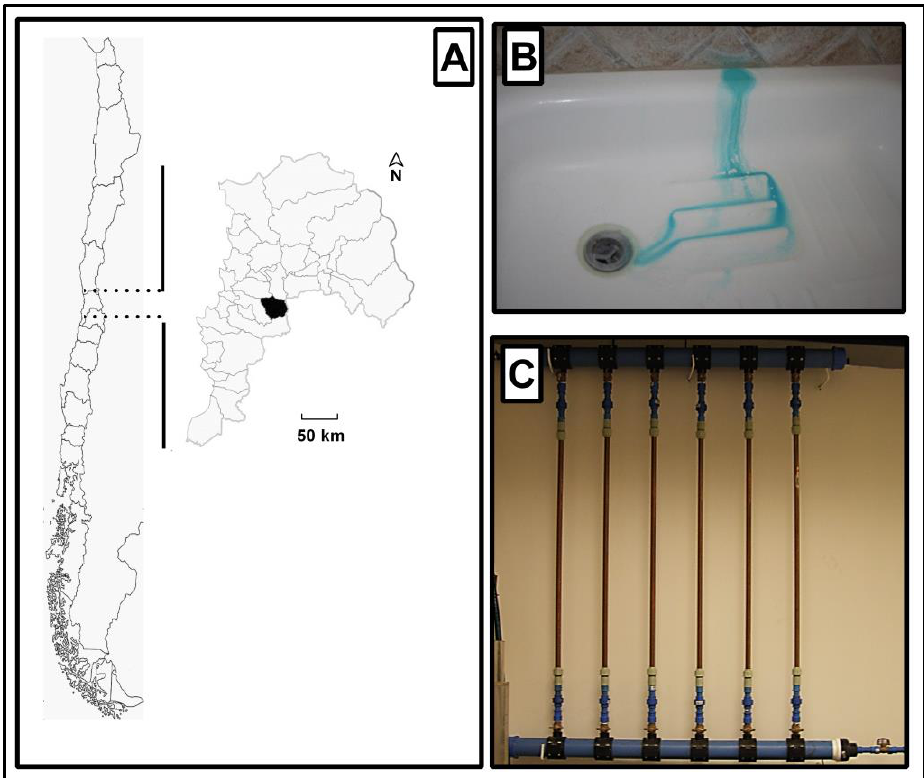
Figure 1. ( A ) Map of Chile highlighting the location of the sampling point in the central region. ( B ) Blue-water phenomenon observed in local premise plumbing. ( C ) Sampling system installed in the local premise plumbing system.